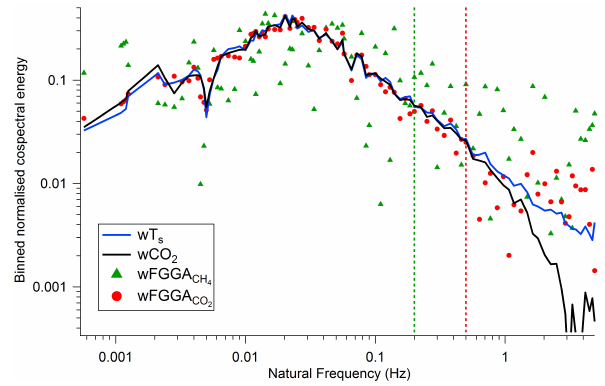
Fig. 1. Averaged smoothed normalized cospectra from 74 daytime ensembles of sonic temperature, an open-path CO 2 sensor, and the FGGA CO 2 and CH 4 plotted as a function of natural frequency with an average stability and wind speed range of z/L = − 0.074 and =2.7 ± 0.5m s − 1